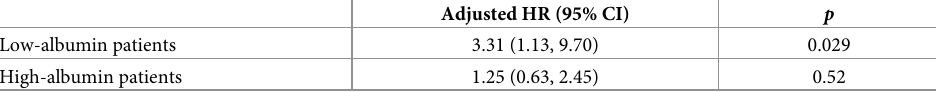
Adjusted HRs of the low-Zn group to the high-Zn group are shown. HRs were adjusted for baseline characteristics, such as age, male sex, BMI, DM, cardiovascular disease, ln(eGFR), ln(CRP), serum albumin levels, hemoglobin levels, dipstick proteinuria, ARBs or ACE inhibitors, and